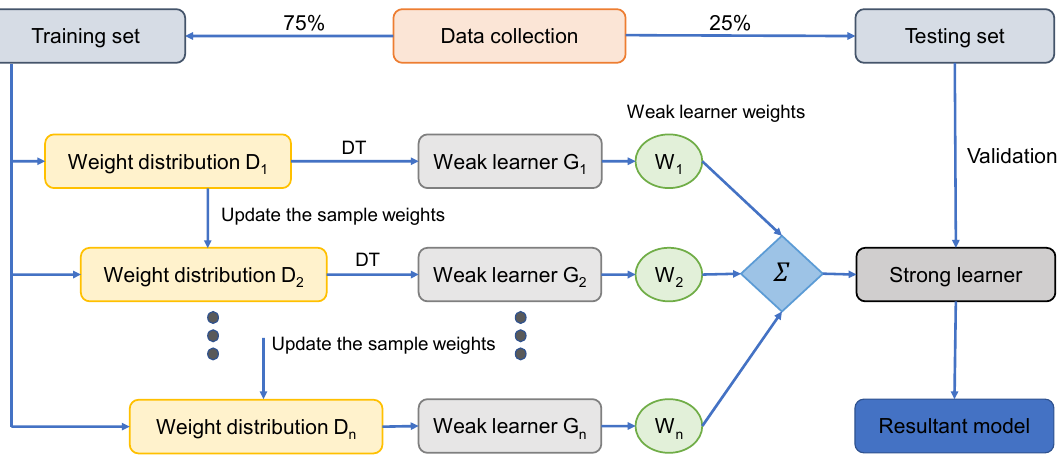
Figure 4. Decision tree schematic representation [14]. Reprinted with permission from ref. [14]. Copyright 2022 Elsevier B.V.